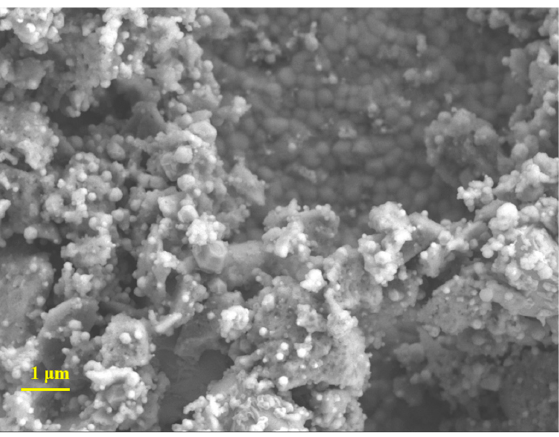
Figure 17. X-ray diffractograms collected from the Pd infiltrated Ag-LSCF anode surface after test- ing (LSCF PDF 04-019-6360, YSZ PDF 04-016-2113 and, Ag PDF 00-004-0783).